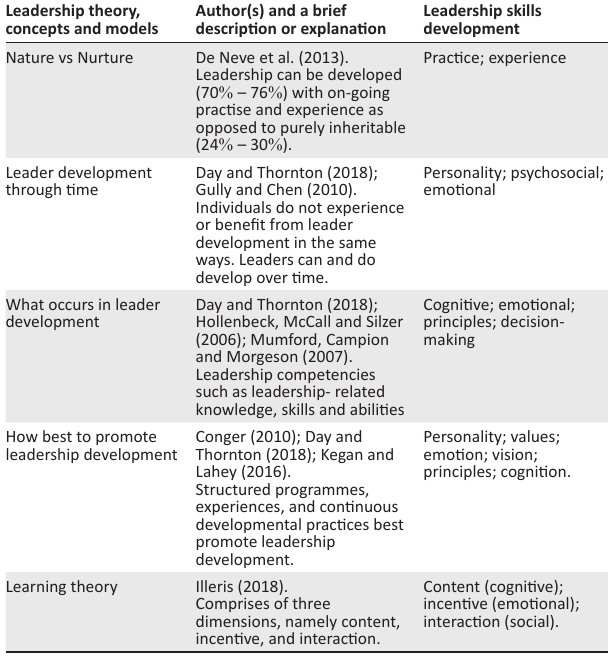
TABLE 2 : Leadership skills development